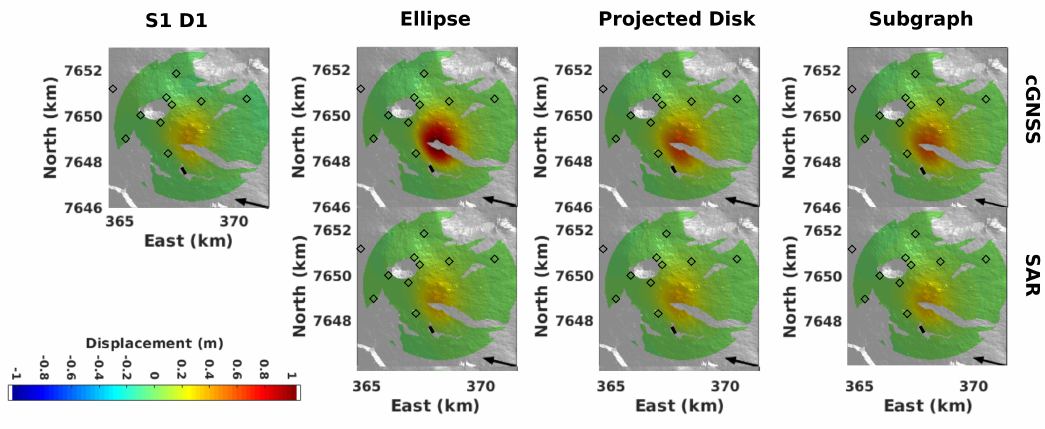
Figure 10. Comparison of inversion results for validation test using interferogram S1 D1. Wrapped interferogram S1 D1 ( first column ) and modeled interferograms computed with the best models determined with the Ellipse method ( 2nd column ), Projected Disk method ( 3rd column ) and Subgraph method ( 4th column ). Inversion is done with continuous GNSS data alone ( top ) or with SAR S1 D1 data alone ( bottom ). Black segment markss the location of the eruptive fissure. Diamonds represent the location of permanent GNSS